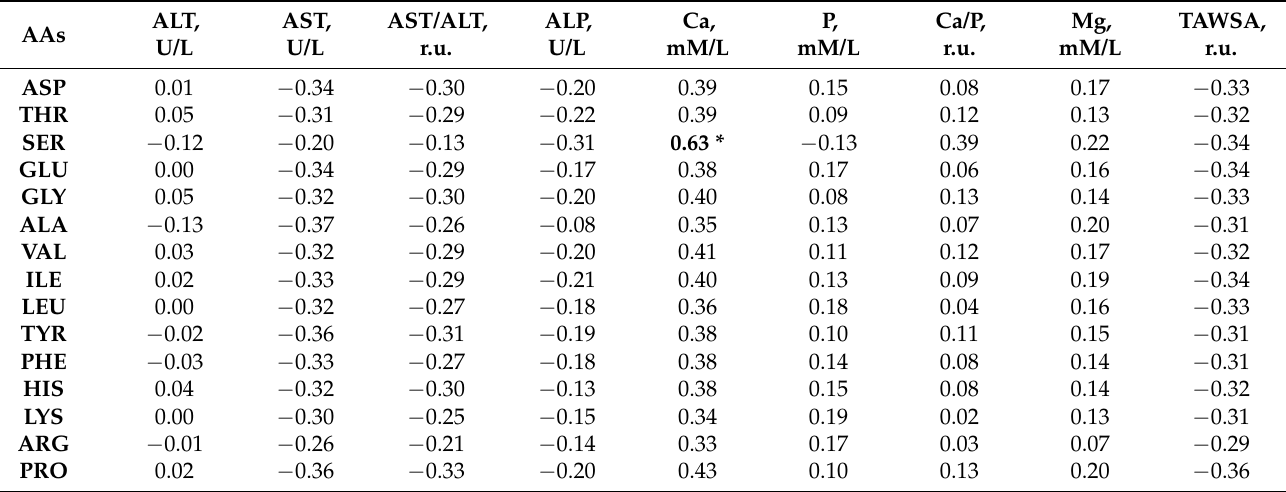
Table 3. The correlation coefficients between all obtained amino acids and the major biochemical parameters of the blood serum of Duroc pigs of the group one (65 days): ALT, alanine aminotrans- ferase; AST, aspartate aminotransferase; ALT/AST, alanine to aspartate aminotransferases’ ratio; Ca, calcium; P, phosphorus; Ca/P, calcium to phosphorus ratio; Mg, magnesium; TAWSA, total amount of the water-soluble antioxidants (n = 12).